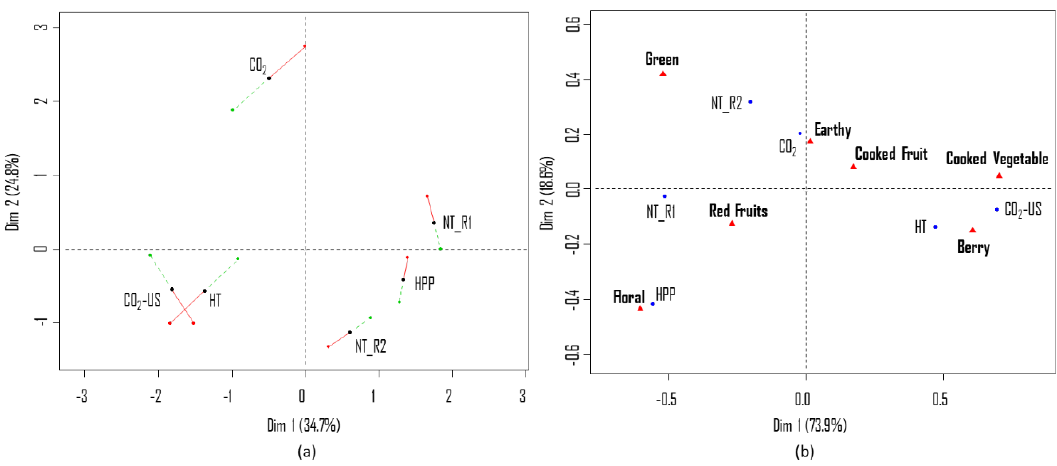
Figure 1. ( a ) MFA individual factor map (first two dimensions) based on odor perception (PM / napping) with superimposed partial points from the two evaluation sessions (S1: red dot and S2: green dot) for each type of preservation treatment considered (NT, HT, HPP, CO 2 , CO 2 -US) at the beginning of the storage test (t 0 ). ( b ) CA bi-plot obtained from the CATA questionnaire based on odor perception.